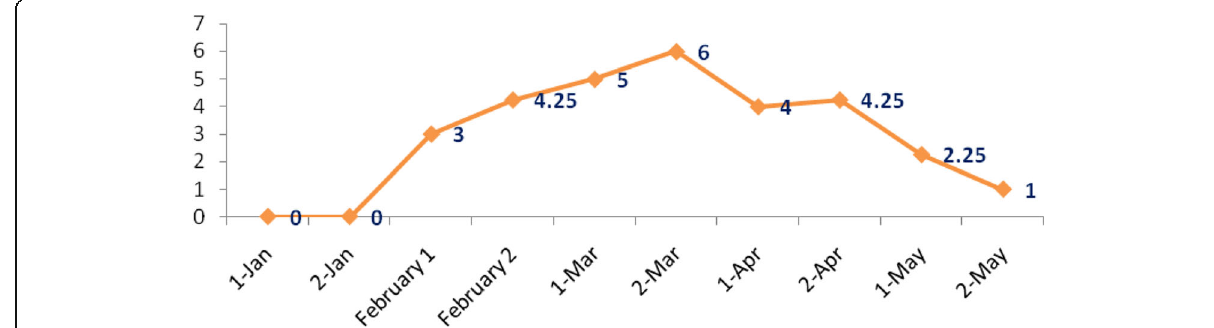
Fig. 2 Parasitization by Campoletis chlorideae recorded on larvae of H . armigera in berseem/trap cropping during